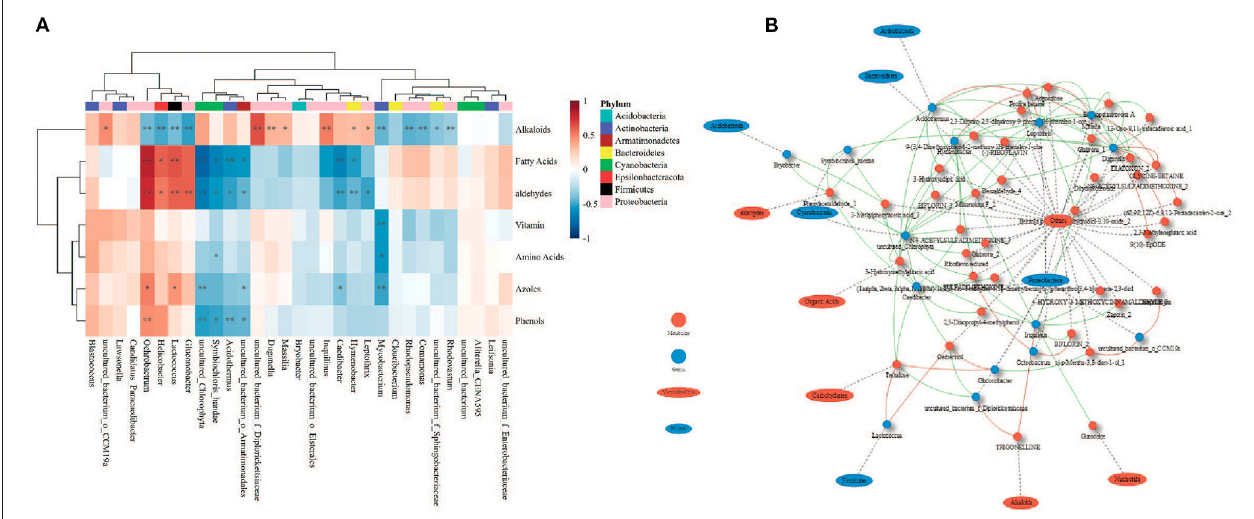
FIGURE 8 | Relationship between metabolites and phyllosphere bacterial communities of Chinese fir. (A) SparCC correlations between metabolite classes and genera; (B) network constructed for strongly correlated genera and metabolites (| R | > 0.6). * p < 0.05, ** p < 0.01. Red lines indicate positive relationships; green lines indicate negative